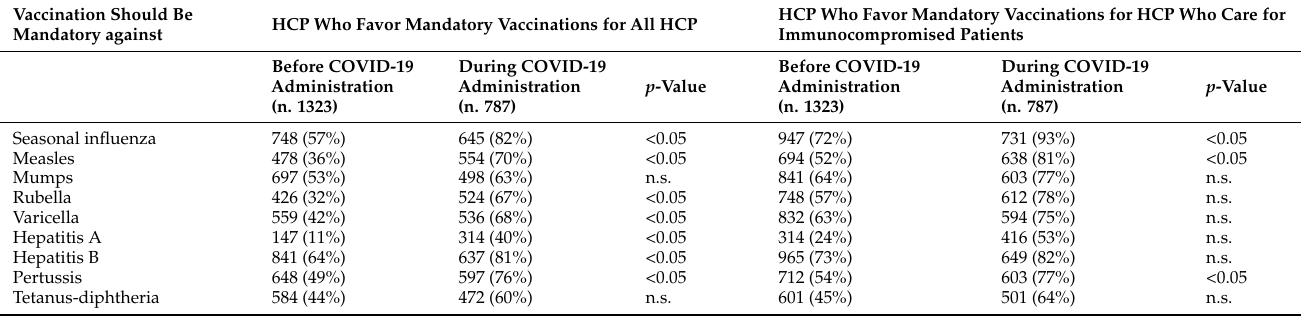
Table 3. Attitudes towards occupational vaccination for HCP.